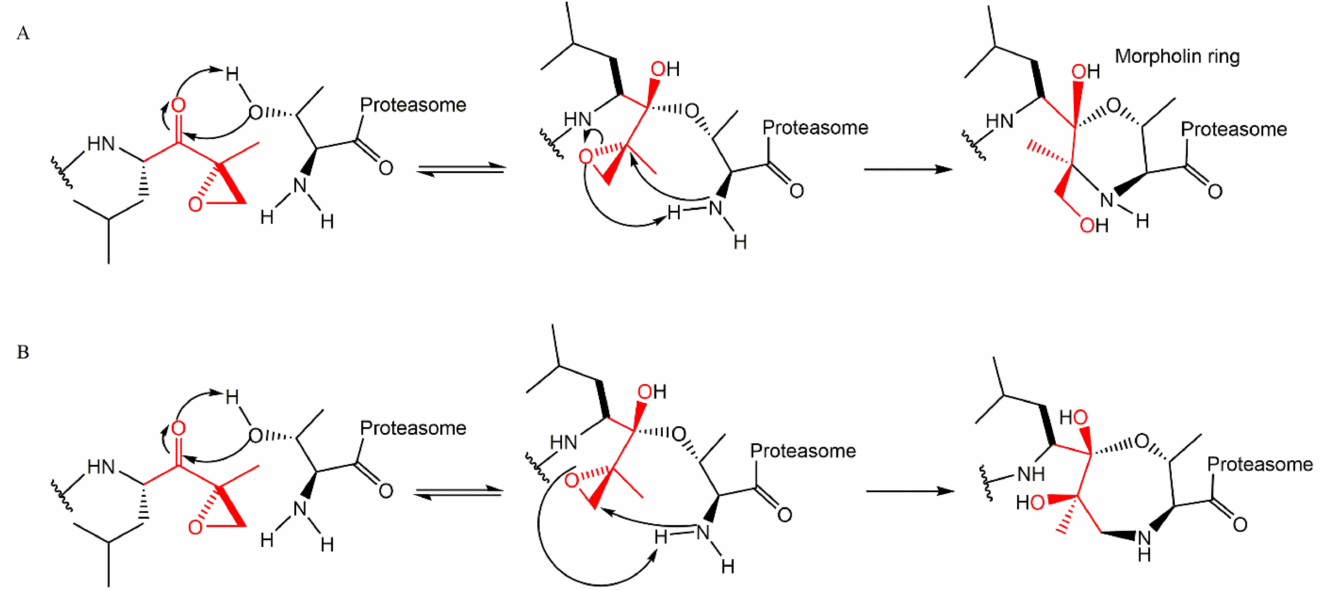
Figure 11. Mechanism of proteasome inhibition by α ’, β ’-epoxyketone inhibitors. The hydroxyl and amine groups from Thr1 react, respectively, with the carbonyl group and α -carbon or β -carbon of epoxide group from inhibitor, promoting the formation of a 6-membered ring ( A ) and 7-membered ring ( B ), respectively